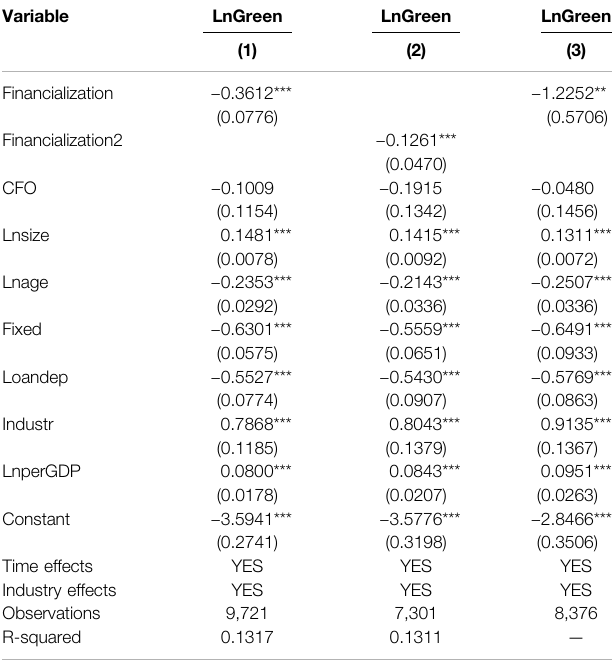
TABLE 3 | Estimation results of the impact of corporate fi nancialization on green technology innovation